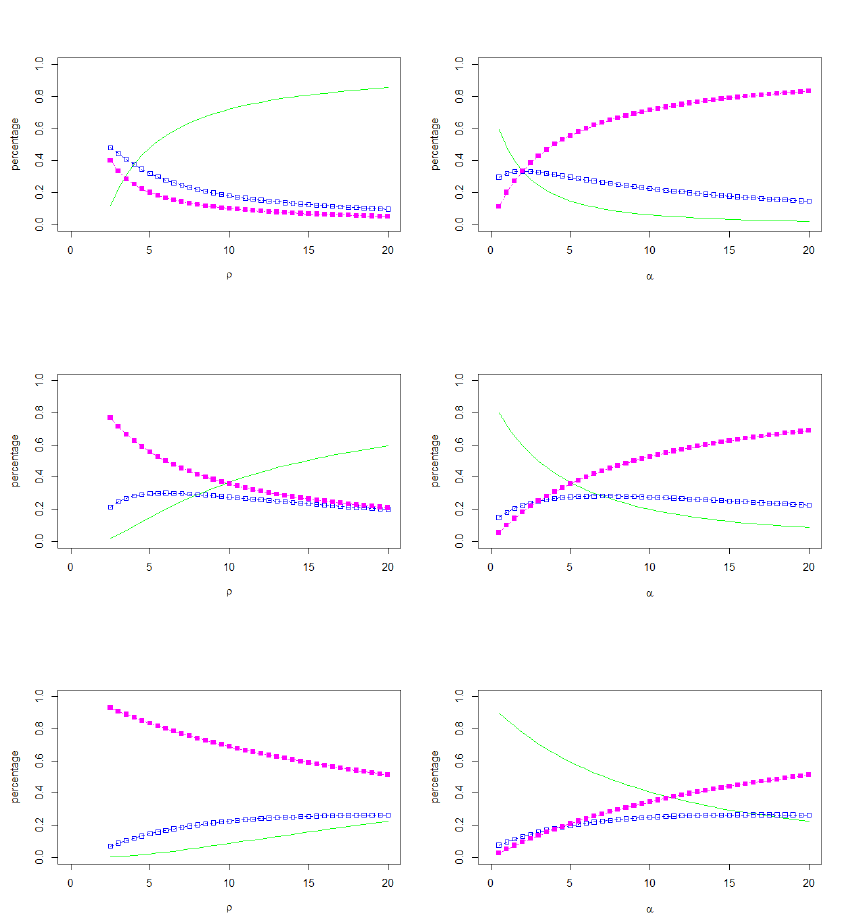
Figure 1. Percentages of the extended biparametric Waring ( EBW ) variance components: randomness (green solid line), liability (blue dashed line) and proneness (purple dotted line). Column 1 has values of α = 0.5,1, 5 and 20, respectively, for ρ from 2.1 to 20. Column 2 has values of ρ = 2.5,5, 10 and 20, respectively, for α from 0.1 to